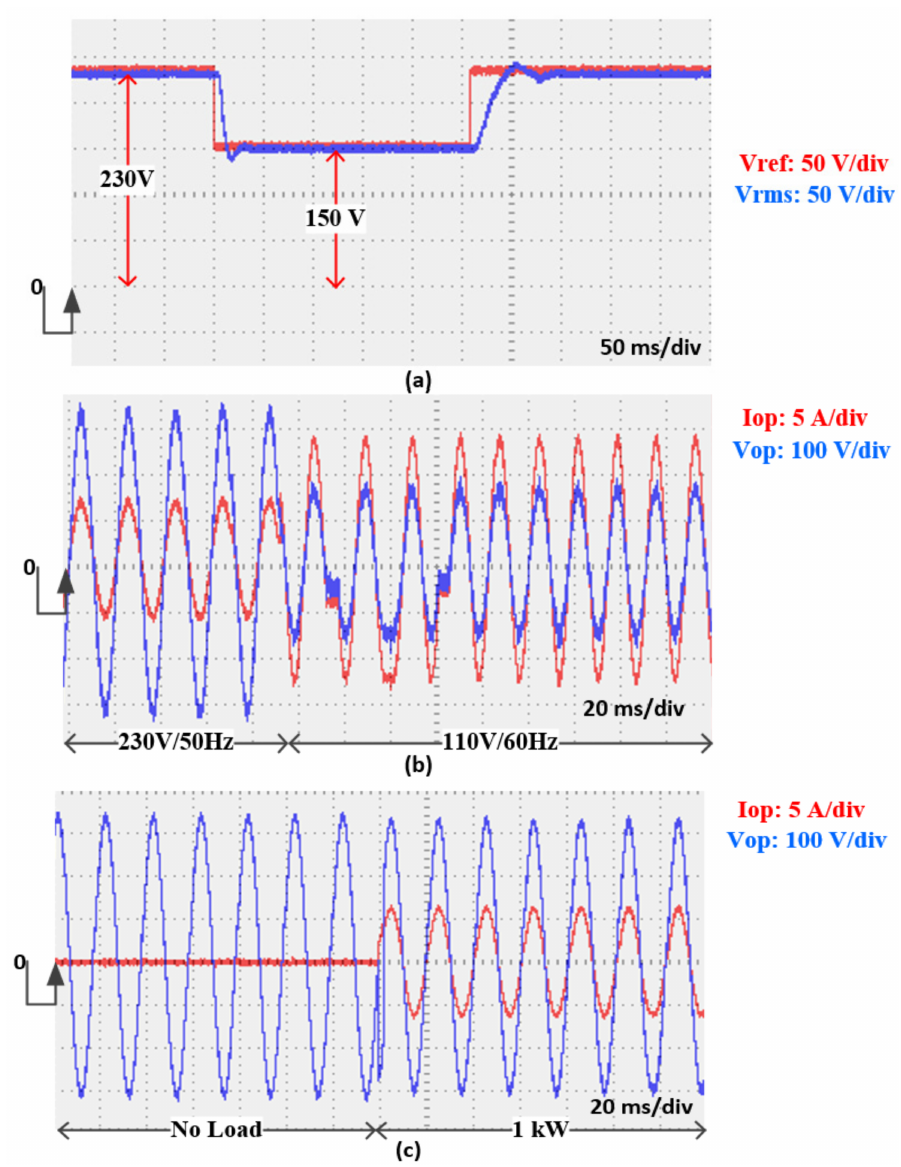
Figure 16. ( a ) Pulse voltage change response of the controller. ( b ) Fixed load voltage and frequency control response. ( c ) No-load to half rated load step change